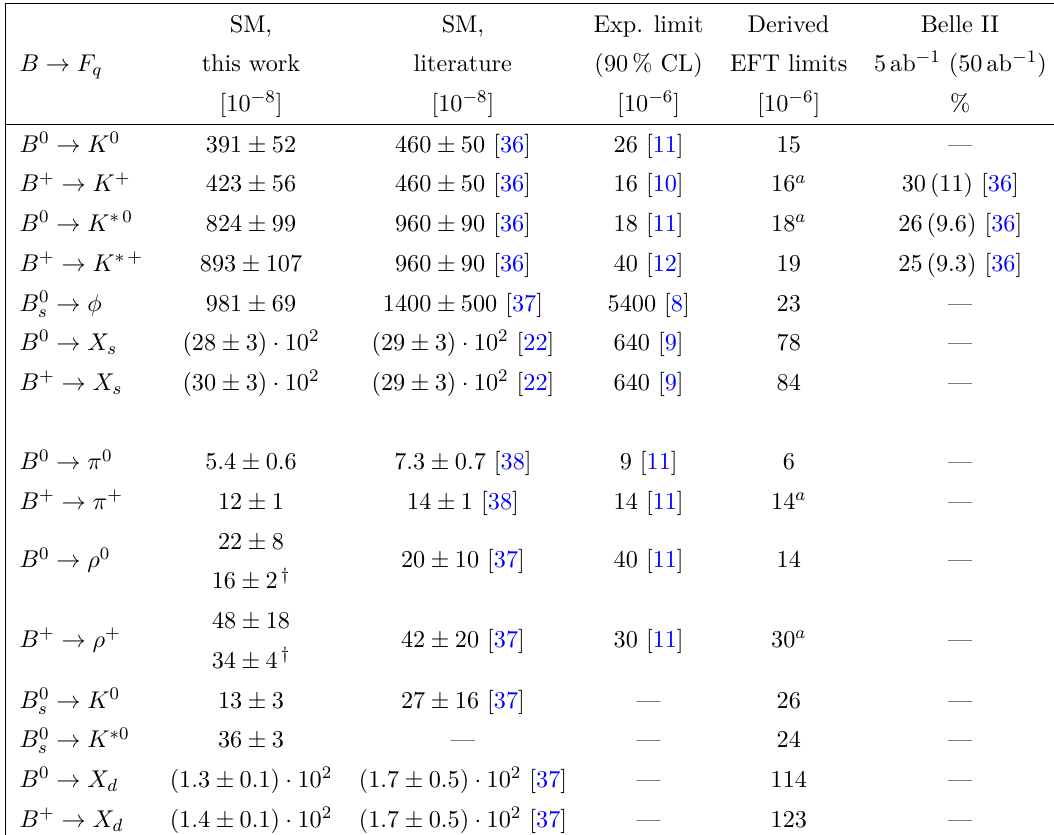
Table 2 . SM predictions for dineutrino modes (this work, second column) as well as SM predictions available in the literature (third column). Current experimental limits at 90 % CL are displayed in the fourth column. Derived EFT limits using eqs. (4.1) and (4.2) are displayed in the fifth column, while Belle II sensitivities for 5 ab − 1 ( 50 ab − 1 ) from ref. [36] are displayed in the last column. ) , see appendix C.2 for details. Differences between our SM a Input. † Normalized to B ( B → ρ ‘ ν ‘ exp predictions and the literature are due to updated CKM values and form factor